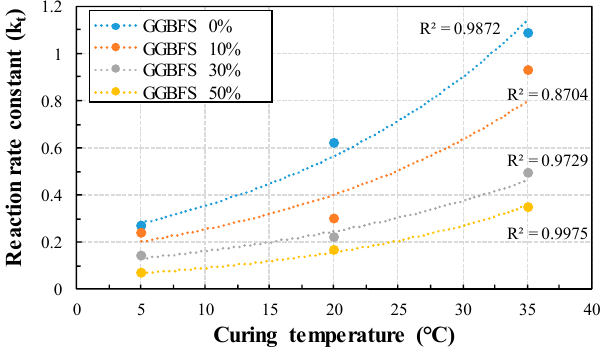
Figure 5. The effect of temperature on the rate constant with GGBFS replacement ratio.